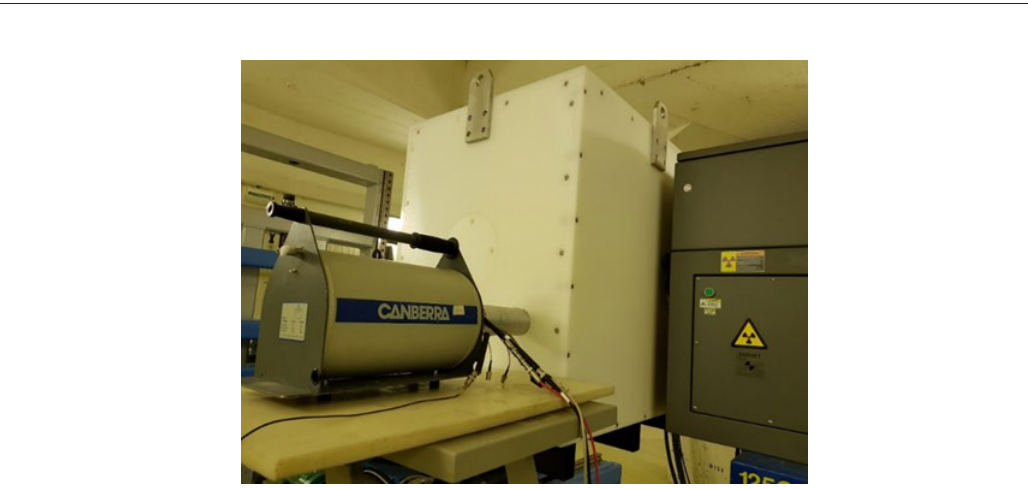
Fig. 10. Neutron activation measurement: view of the setup No. 2. HPGe detector placed on the side of the neutron cell.